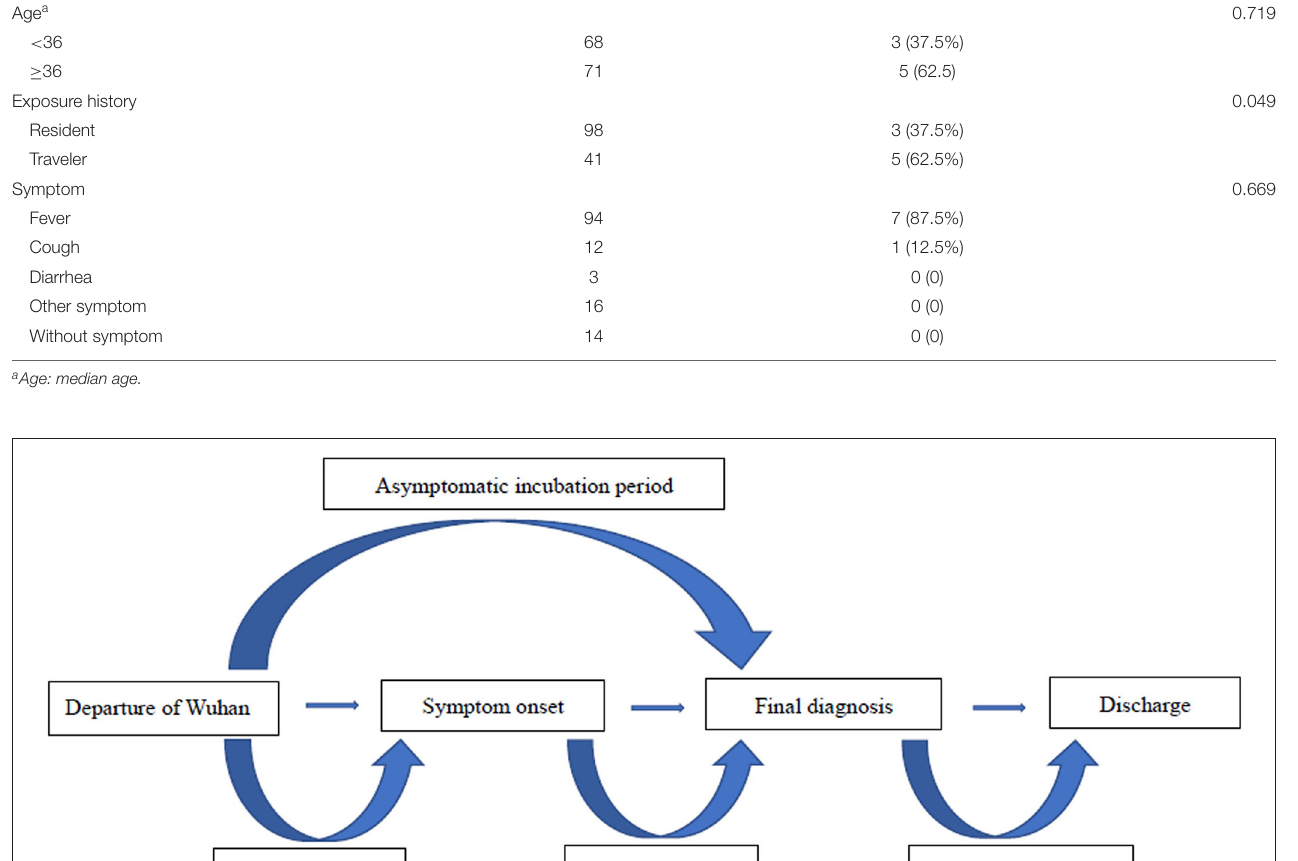
and the Mann–Whitney U-test and Kruskal–Wallis H-test were applied when the cases did not fit the normal data distribution. Bilateral P ≤ 0.05 was considered statistically significant. All analyses were performed using SPSS